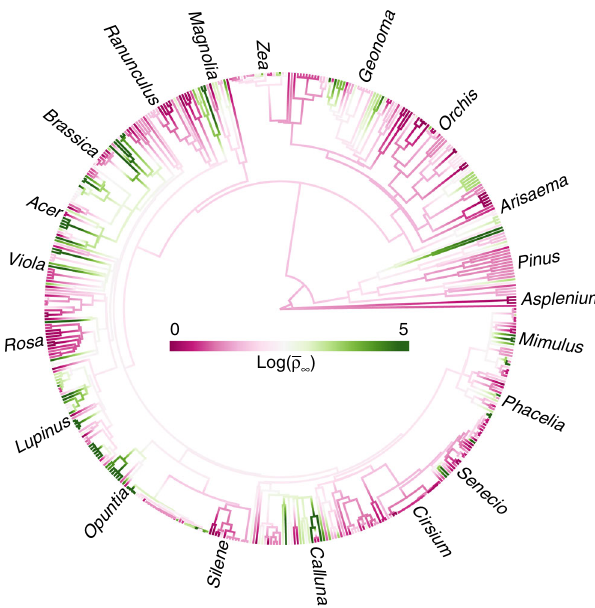
Fig. 3 Phylogenetic signal in potential to recover from demographic disturbance. Phylogram, showing the magnitude of the upper bound on demographic inertia (log( (cid:1) ρ 1 )) and its distribution across the plant Kingdom. Each tip of the phylogeny represents a species in our dataset. For display purposes, only a subset of ‘ familiar ’ genera are labelled. High (green; max = 5) and low (pink; min = 0) values of log(demographic inertia) quantify the potential to recover from demographic disturbance. The clustering of colours across the phylogeny shows that closely related species tend to share similar potential for demographic ampli fi cation. Source data are provided as a Source Data fi